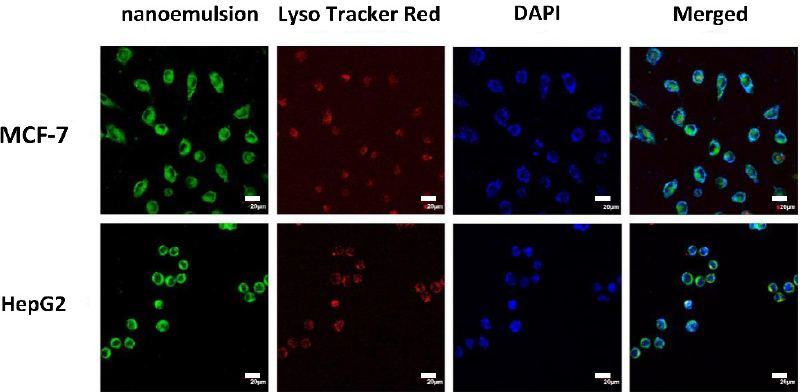
Figure 7. Cellular localization of CAS-loaded nanoemulsions after incubating with MCF-7 and HepG2 for 20 min. Nanoemulsions, lysosomes, and nuclei were labeled by coumarin-6 (first column, green color), Lyso-Tracker red (second column, red color), and DAPI (third column, blue color), respectively. The scale bar in the CLSM image is 20 μ m.